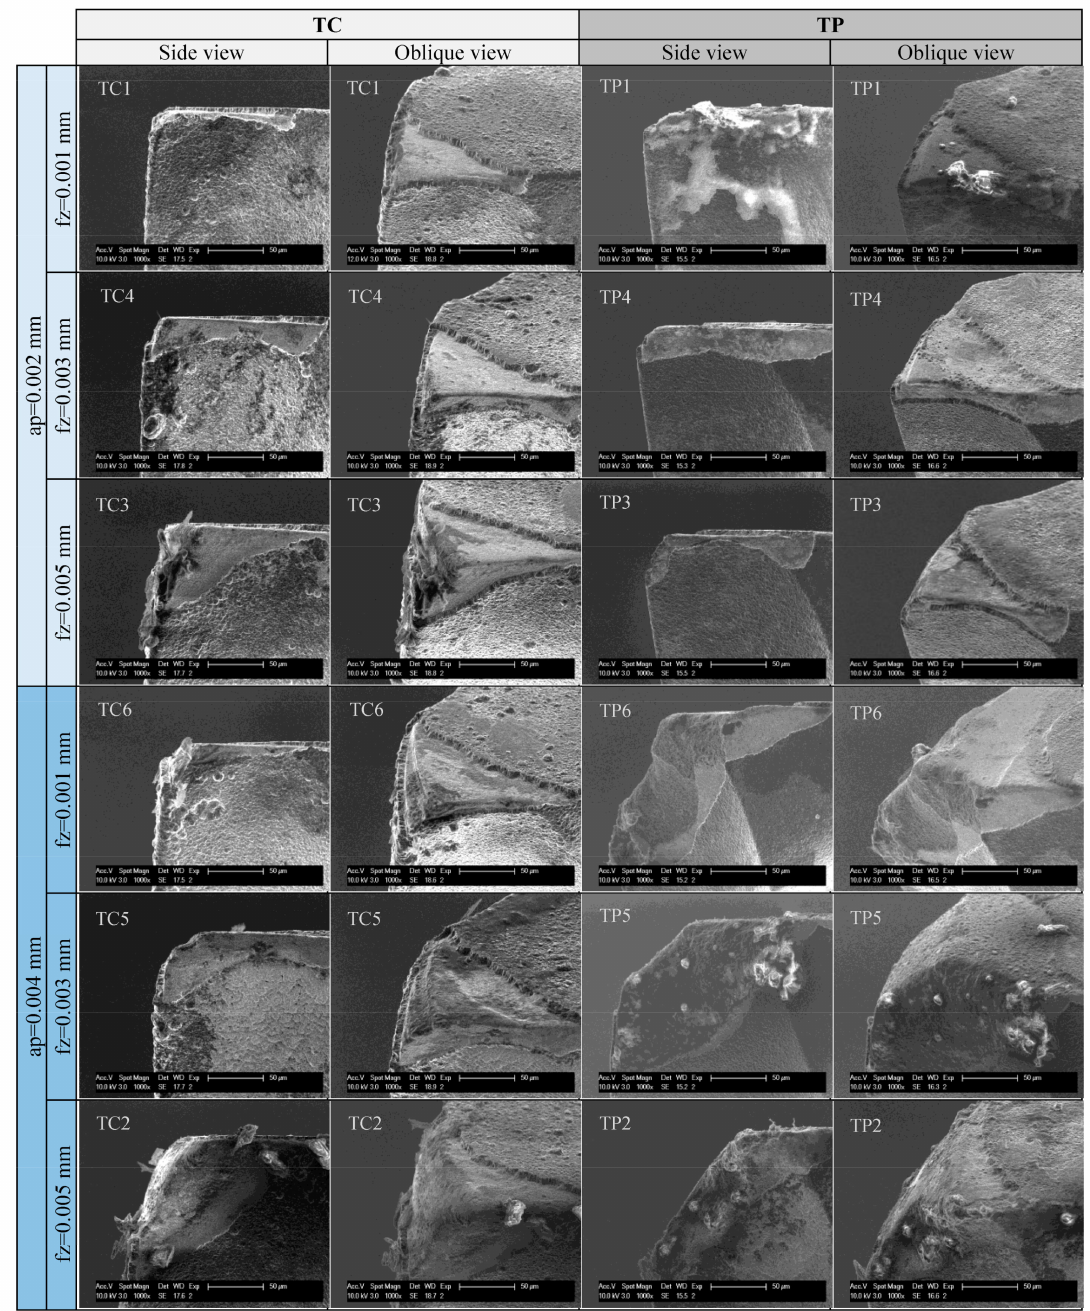
Figure 9. Tool tip wear of the conventional diamond-coated tool—TC and nano diamond- coated